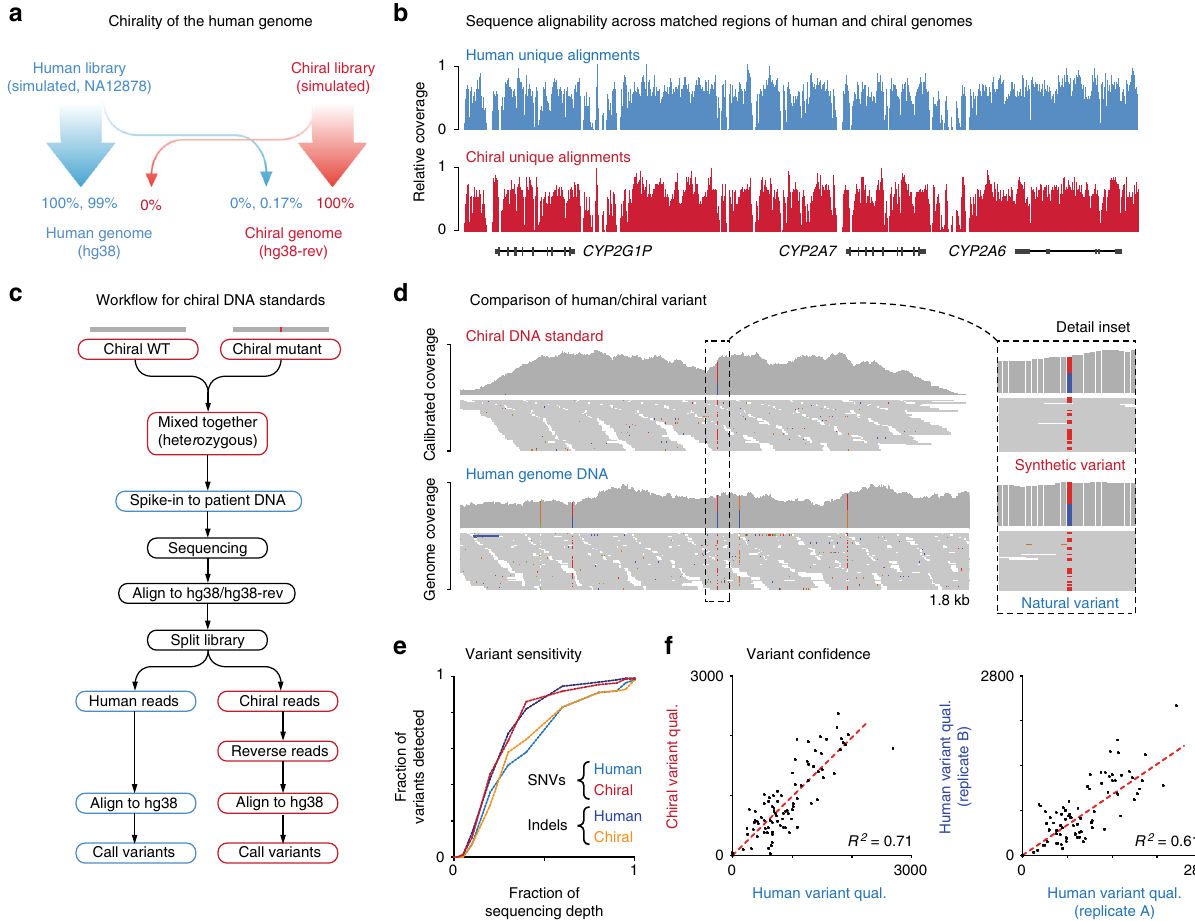
Fig. 5 Matched performance of chiral DNA sequence pairs during variant detection. a Schematic summarizes the alignment rate for simulated and experimental NGS libraries to the human genome ( hg38 ; blue) and a mirrored human genome sequence ( hg38-rev ; red). b Coverage of uniquely aligned reads (MapQ > 10) to a matched region of the human ( hg38 ; blue) and chiral ( hg38-rev ; red) genome illustrates concordant mapability pro fi le. c Work fl ow schematic describes the analysis of variants represented with chiral DNA standards, in parallel with their human variant counterparts. d Genome browser view showing alignment coverage from human genomic DNA (NA12878) and a matching chiral DNA standard at the site of a heterozygous single- nucleotide variant (SNV). Inset shows detail of human/chiral alignments at SNV site. e Plot shows variant detection sensitivity relative to sequencing depth for human/chiral SNVs (blue/red) and indels (navy/orange). f Scatter plots show concordance of variant con fi dence scores (Qual.) between human/chiral variants (left) and identical human/human variants between replicate experiments